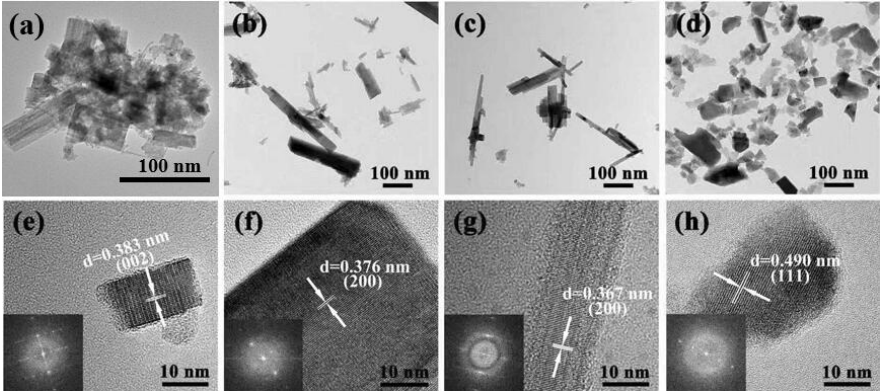
Figure 2. ( a – d ) TEM images of S1, S2, S3, S4; ( e – h ) HRTEM images of S1, S2, S3, S4.